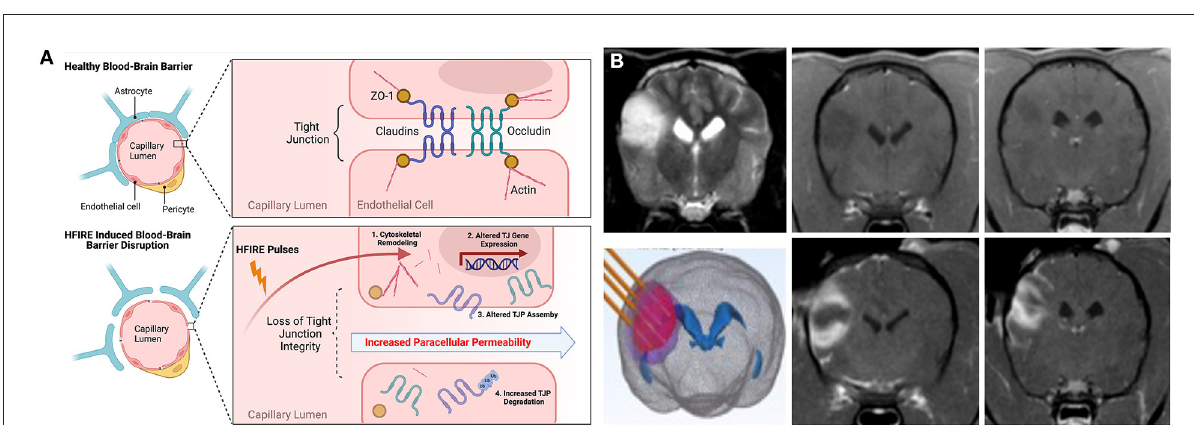
FIGURE7 HFIRE-induced BBBD. (A) Schematic representation of mechanisms of HFIRE-induced BBBD (11) TJP, tight junction proteins; UB, ubiquitinated protein. Figure panel created with https://BioRender.com. (B) HFIRE induced BBBD in a non-enhancing canine oligodendroglioma. Top row demonstrating pre-treatment T2W (left panel) and T1W post-contrast images (middle and right panels) of the tumor with no abnormal areas of contrast-enhancement. HFIRE treatment (bottom row) planning image with stereotactic electrodes inserted into the tumor (left panel), and post-contrast T1W images (middle and right panels) demonstrating peripheral ring of gadolinium enhancement surrounding the tumor following HFIRE